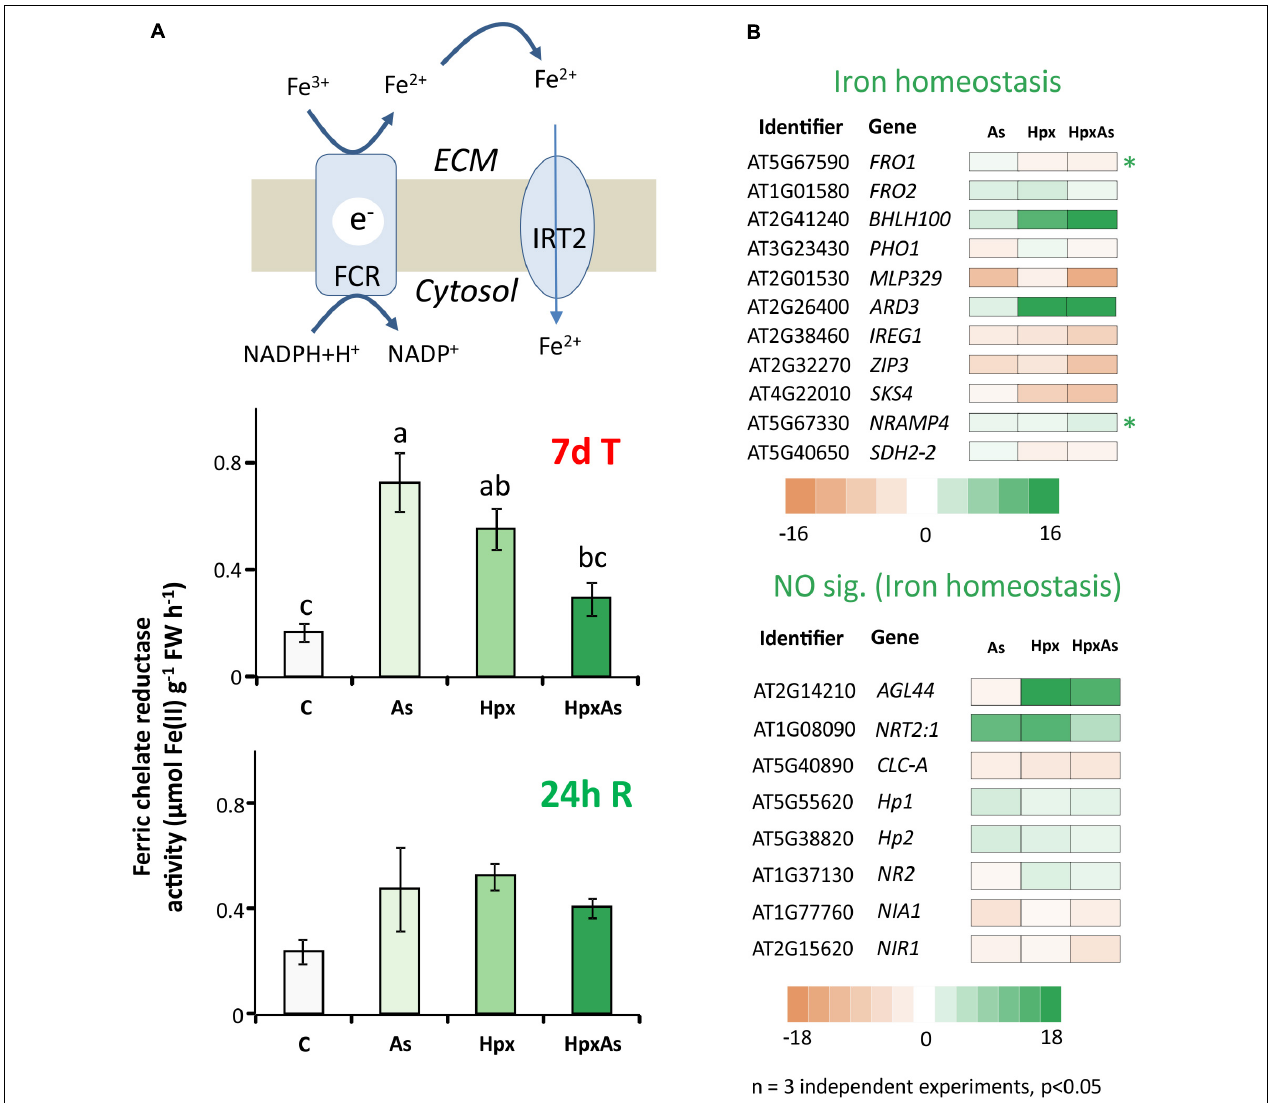
FIGURE 5 | Perturbation of Fe-uptake and assimilation as evident from transcriptomic and biochemical analyses. (A) Ferric chelate reductase activity was measured in intact Arabidopsis roots using ferrozine based complexation of Fe(II). The obtained data were compared among different treatments after 7 days of treatment and after additional 24 h of reaeration. The data are means ± SE, n = 5, (5 individual plants, 2 independent experiments, Tukey’s test, p < 0.05). (B) Stress-induced significant changes (–2 ≥ fc linear ≥ 2, FDR p ≤ 0.05) in Fe-homeostasis-related transcript amounts are presented in heat maps. The heat maps are categorized based on core Fe- uptake-, assimilation- and metabolism-related genes and those involved in NO generation. They all have a putative role in Fe-homeostasis and root development regulation. Transcripts with unique response to HpxAs (–2 ≥ fc linear ≥ 2 for HpxAs, FDR p ≤ 0.05 and either response below this threshold for As, Hpx or response statistically not-significant) are marked with an asterisk. The complete gene lists with transcript amounts under different treatments for Fe and NO are given in Supplementary Table 4